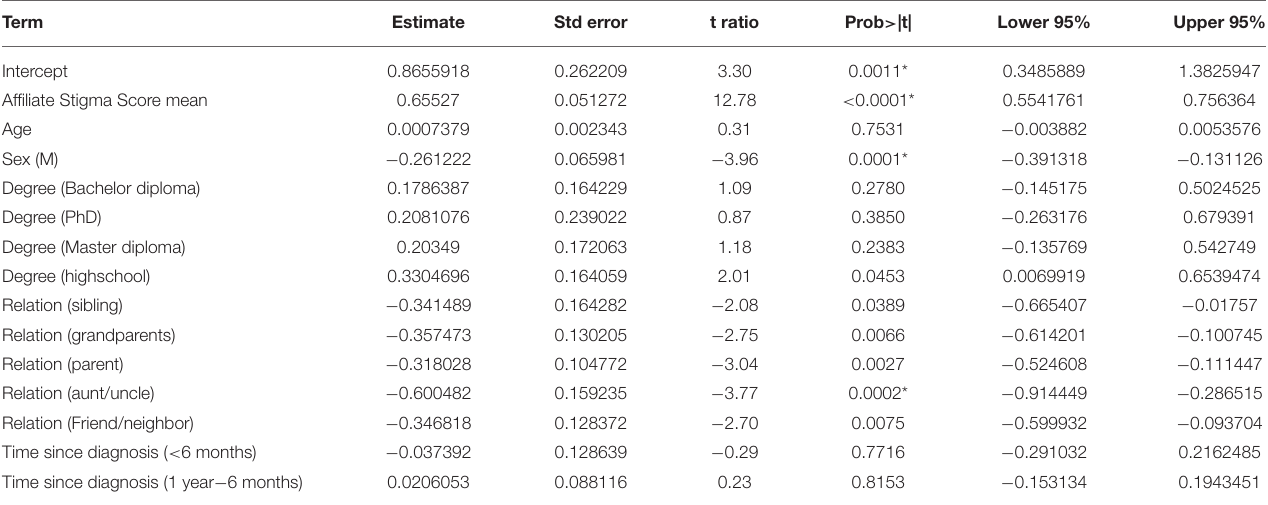
TABLE 2 | Impact of affiliate stigma score on mental well-being, adjusted for age, gender, diploma, relationship with the person with dementia and time since diagnosis. Term